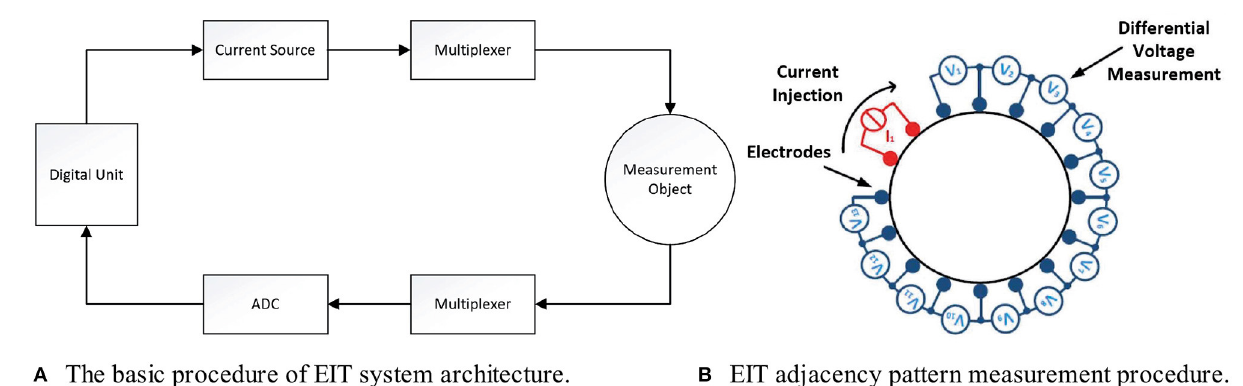
FIGURE 1 | General structure of an EIT system: In (A) the overall system structure is shown, where a central unit controls the whole system and processes measured values. In (B) the adjacency measurement protocol for the first cycle is shown, where red indicates electrodes used for current injection and blue indicates electrodes used for voltage